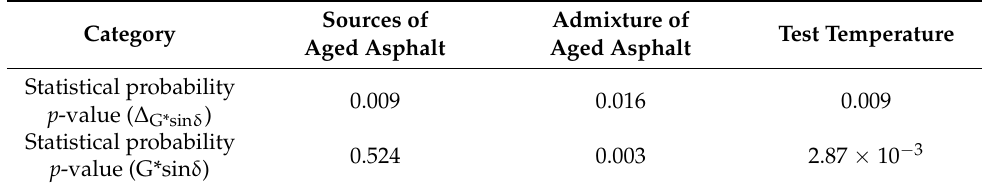
Table 6. Analysis of variance results for reclaimed asphalt Δ G*sinδ and G*sinδ.